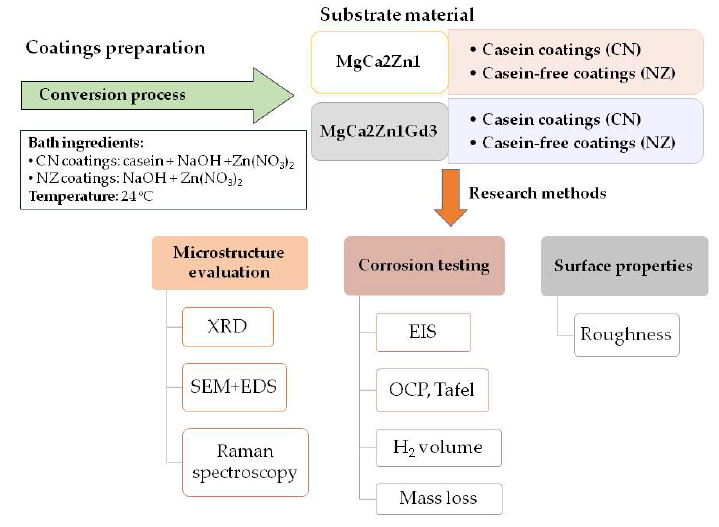
Figure 1. Diagram of research performed in the work.